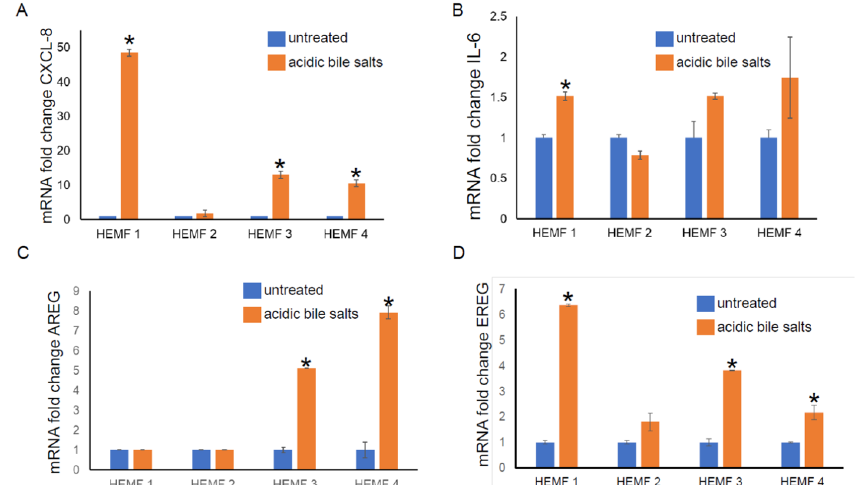
Figure 2. HEMF primary culture (HEMFs 1–4) mRNA fold change of ( A ) CXCL-8, ( B ) IL-6, ( C ) AREG, and ( D ) EREG. * = p ≤ 0.05. Results shown represent the means ± SEM of experiment conducted with primary cell cultures derived from 4 normal human esophagi.